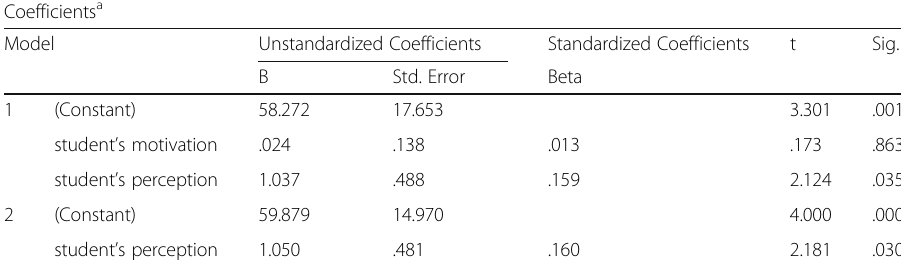
Table 8 Partial Coefficients of Each Independent Variable